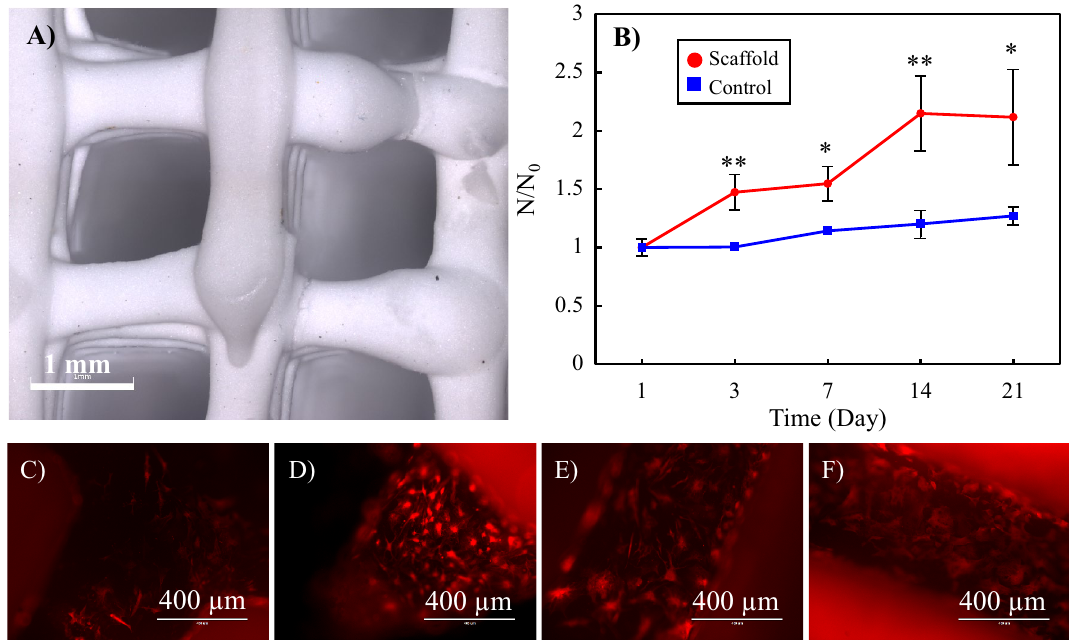
Figure 3. ( A ) 3D confocal laser scanning images of a 3D printed hard scaffold (TCP/HA 80:20) to be used for the Bone Portion of the Plug. ( B )The proliferation rate of human osteoblasts on the scaffolds, as well as the standard cell culture plate (control group). N0 initial number of the cells, N number of cells at each time point. Statistical significance *: p < 0.05, **: p < 0.01, p-values in Day 3: 0.006, Day 7: 0.011, Day 14: 0.006 and Day 21: 0.023. ( C – F ) The fluorescence images of the attached osteoblasts on the scaffolds after ( C ) 3, ( D ) 7, ( E ) 14 and ( F ) 21